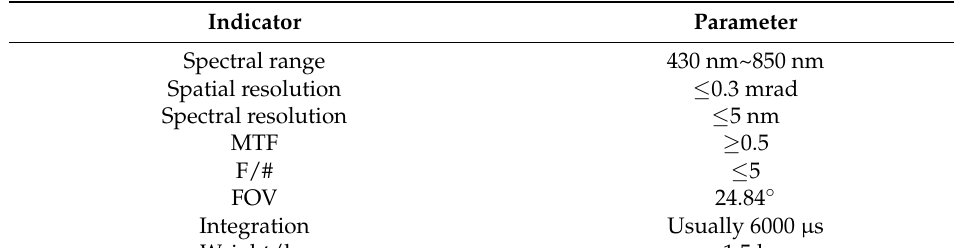
Table 1. Technical indicators for hyperspectral imager.